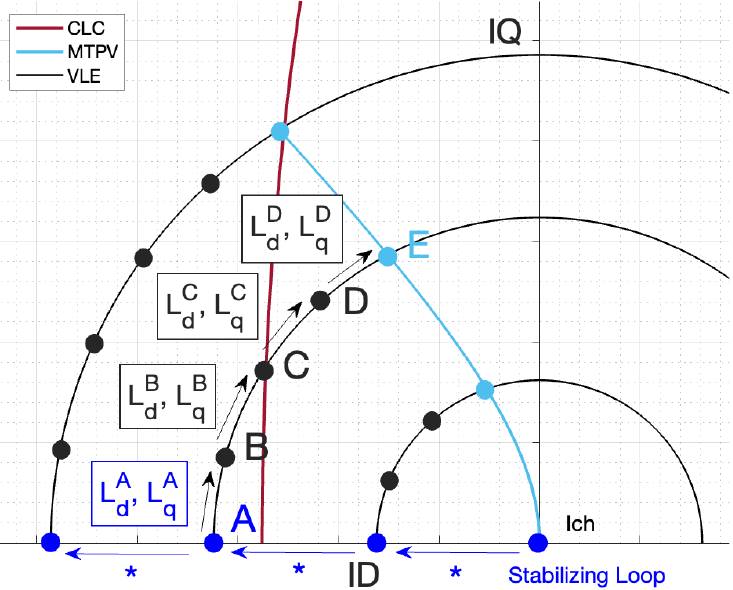
Figure 8. Procedure of MTPV algorithm on the new D-Q reference